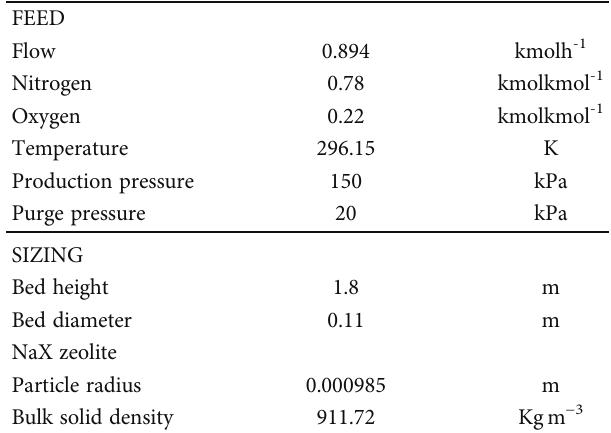
Table 18: Start-up parameters of the PSA process for the puri fi cation and production of medical